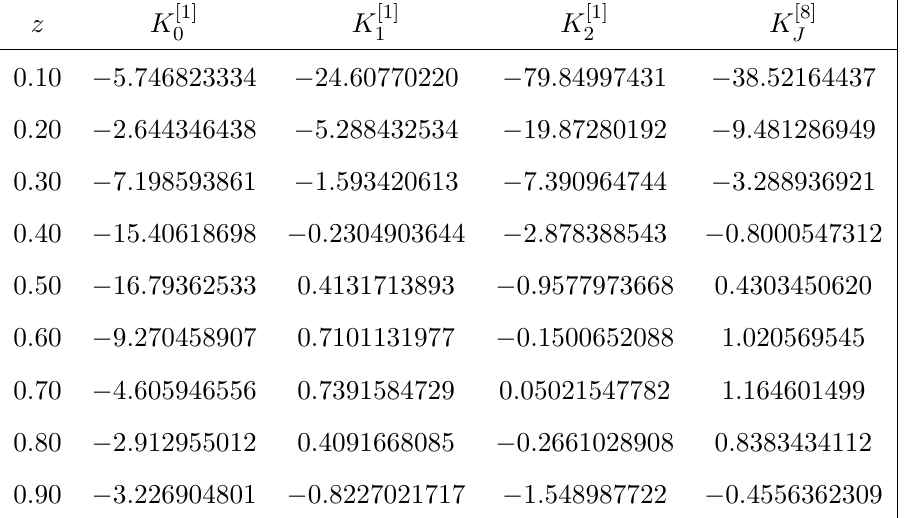
denotes the K-factor of g → b ¯ b ( 3 P [ c ] j